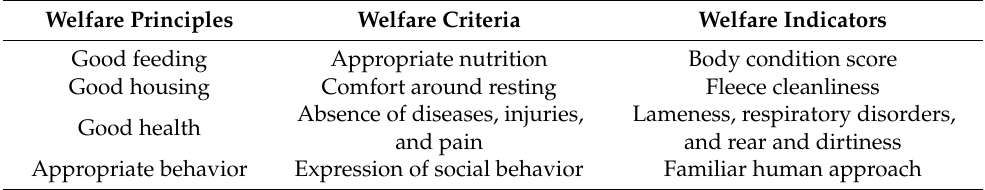
Table 1. Animal welfare indicators for sheep adopted from AWIN